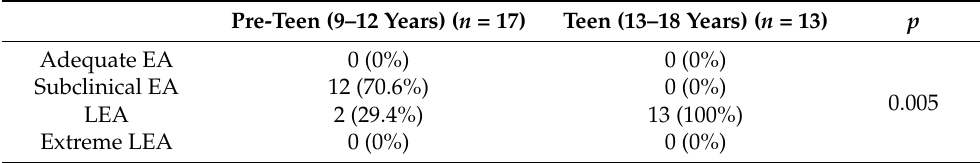
Table 5. Low energy availability (LEA) prevalence of in each study group.